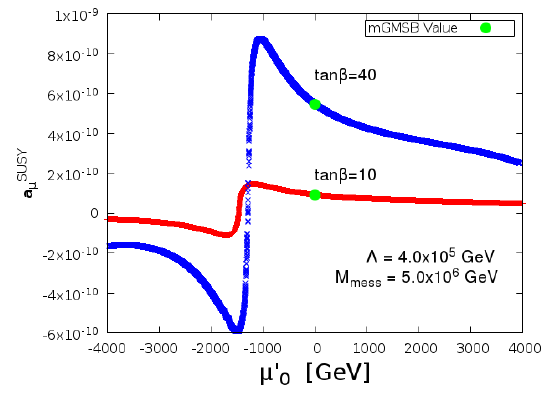
Figure 7 . Plot of a SUSY vs (cid:22) 0 for (cid:12)xed (cid:3) and M mess for tan (cid:12) = 10 and 40. The corresponding (cid:22) 0 mGMSB values of the same quantity are also shown by considering vanishing (cid:22) 0